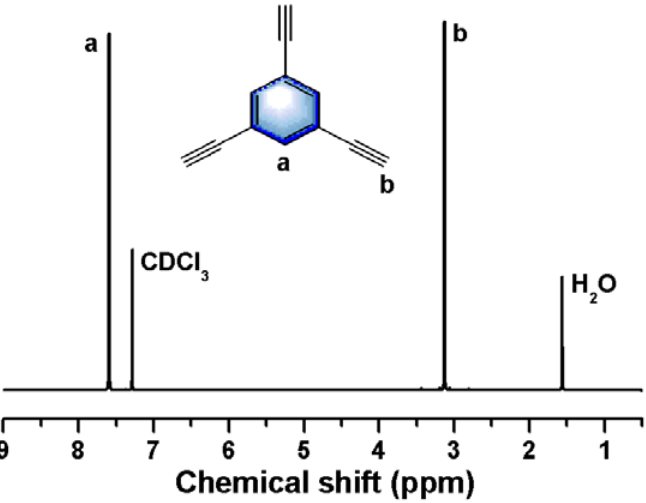
Figure 2. 1 H NMR spectrum of intermediate b .